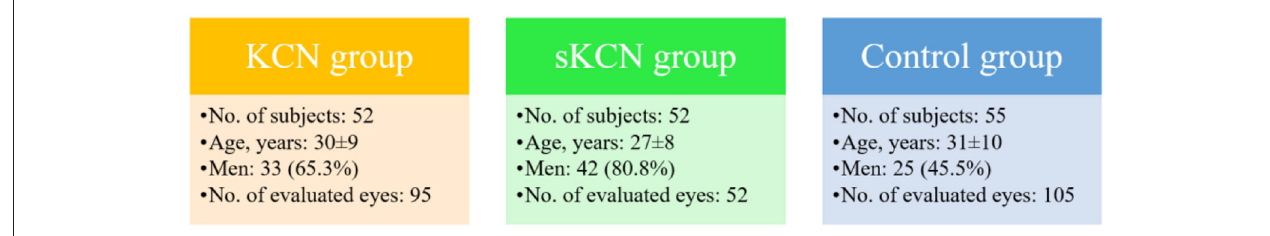
FIGURE 1 | Flowchart with the main characteristics of the evaluated patients. Age is reported as mean ± standard deviation; men are reported as no. and associated percentage.